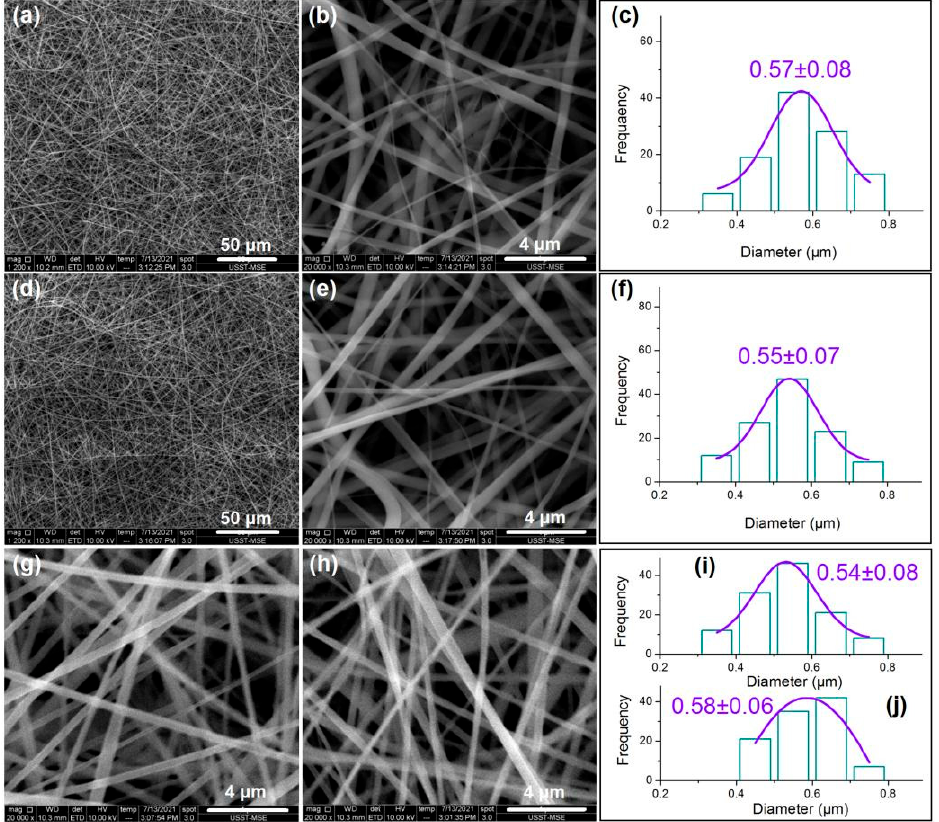
Figure 4. The SEM images of the four sorts of nanofibers: ( a , b ) nanofibers F1 under different magnifications; ( c ) diameter distribution of nanofibers F1; ( d , e ) nanofibers F2 under different magnifications; ( f ) diameter distribution of nanofibers F2; ( g ) nanofibers F3; ( h ) nanofibers F4; ( i , j ) diameter distributions of nanofibers F3 and F4, respectively.